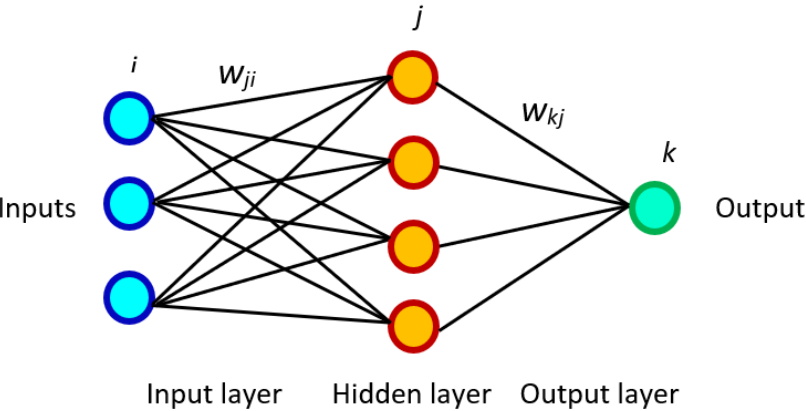
Figure 6. The multilayer perceptron used to differentiate wrist fracture and wrist sprain.